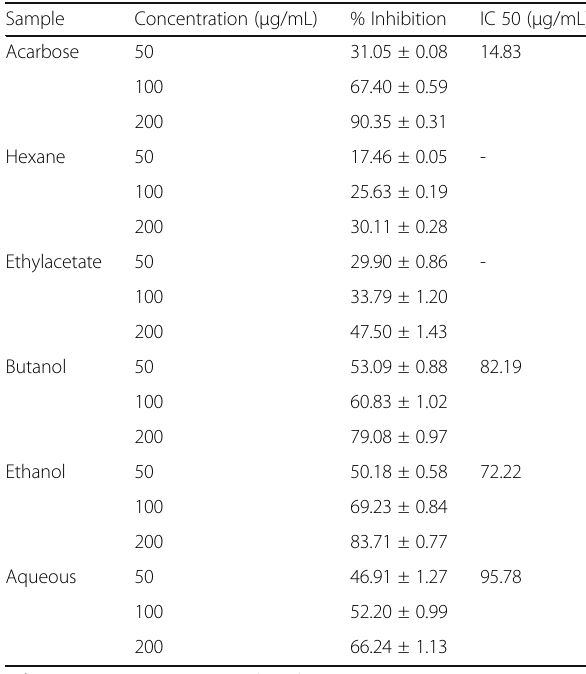
Table 5 In vitro α -amylase inhibition of Cynara scolymus leaves extract and acarbose commercial drug Sample